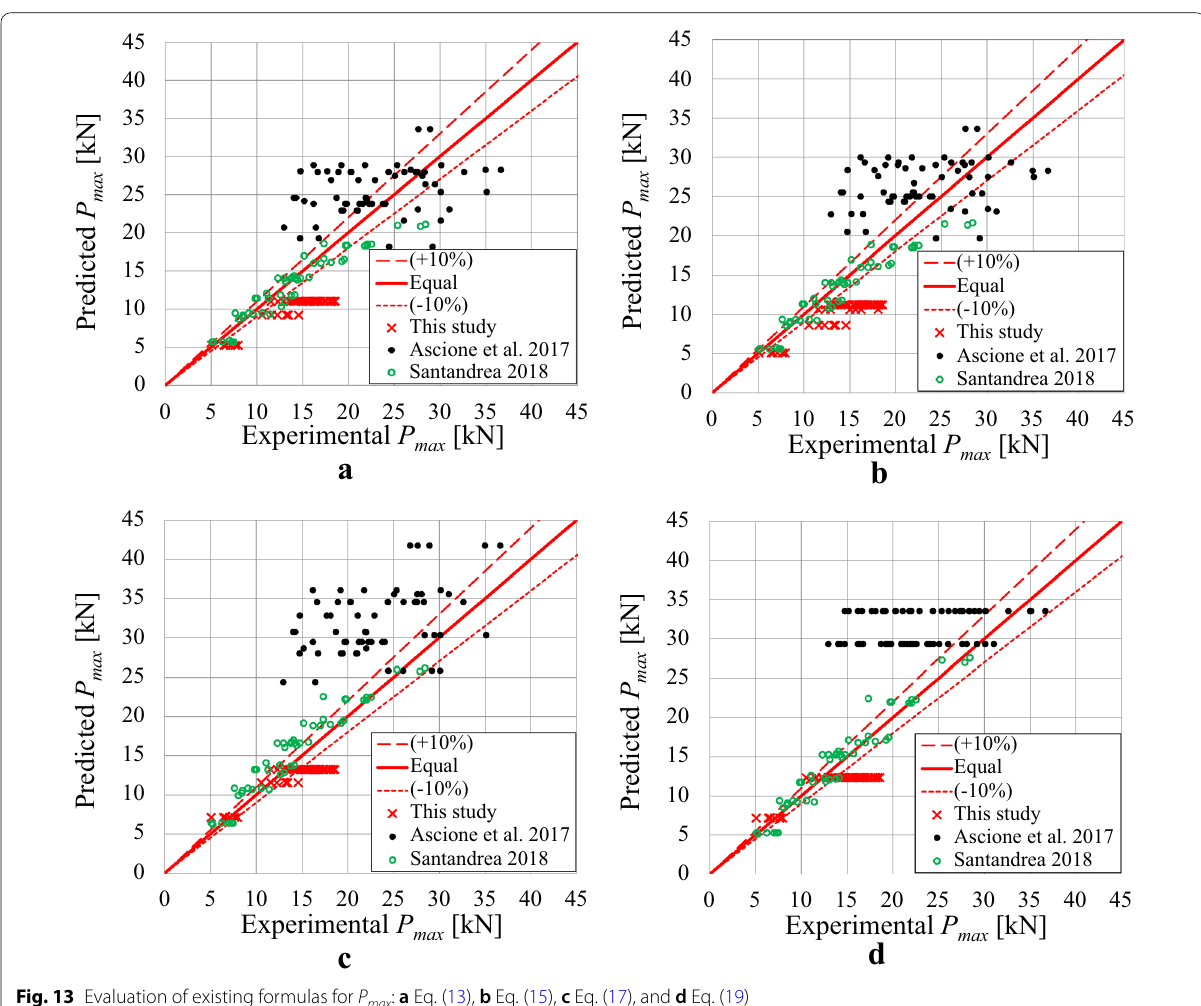
Fig. 13 Evaluation of existing formulas for P max : a Eq. (13), b Eq. (15), c Eq. (17), and d Eq.